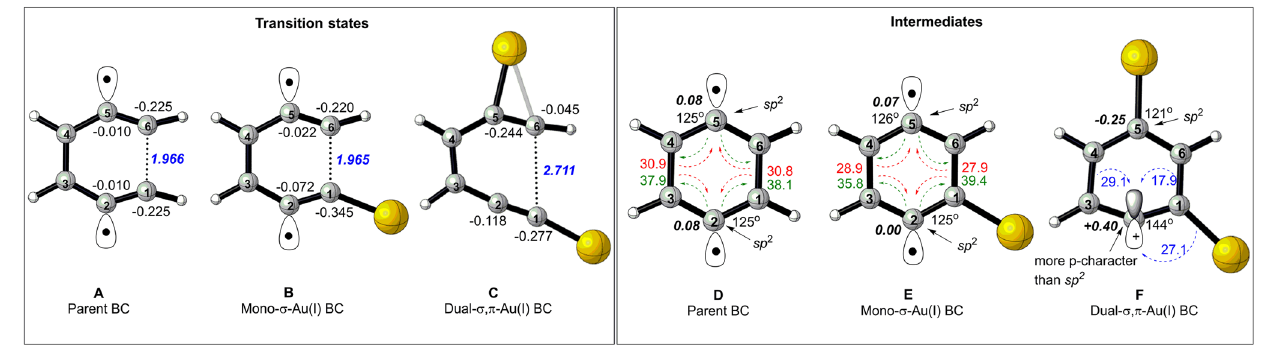
Fig. 6 Bergman cyclization of parent enediyne, mono-Au(I)-acetylide, and dual Au(I)-catalyzed systems. Left: Transition state geometries of BC in parent enediyne ( A ), mono-Au(I)-acetylide system ( B ), and dual Au(I)-catalyzed system ( C ) obtained at the B3LYP/LANL2DZ level. Values in black and blue fonts re fl ect the NBO charges and the C1 – C6 distance, respectively. Right: Geometries corresponding to the parent BC ( D ), mono - σ -Au(I) BC ( E ), and dual σ , π -Au(I) BC ( F ) intermediates. Values and arrows in red correspond to the interaction energies when σ (C1 – C6) and σ (C3 – C4) bonds are symmetrically delocalized into the antibonding orbital of closed shell C2 – C5 diradical. Values and arrows in green re fl ect interaction energies when diradical is symmetrically delocalized into σ *(C 1 – C 6 ) and σ *(C3 – C4) bonds. Values and arrows in blue re fl ect interaction energies when σ (C1 – C6), σ (C3 – C4), σ (C1 – Au) bonds are delocalized into the empty p -orbital of carbocation at C2.